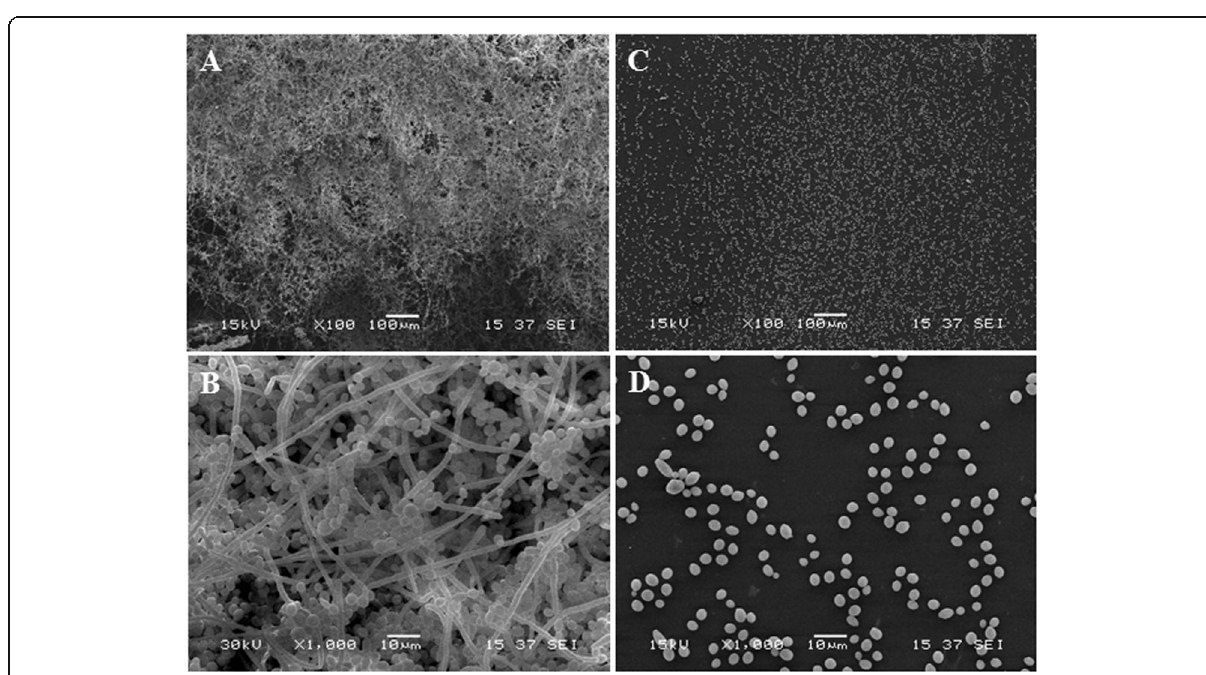
Fig. 3 Scanning electron micrographs of biofilms formed by C. albicans ATCC 28366 grown in the absence (panels a and b ) or presence of